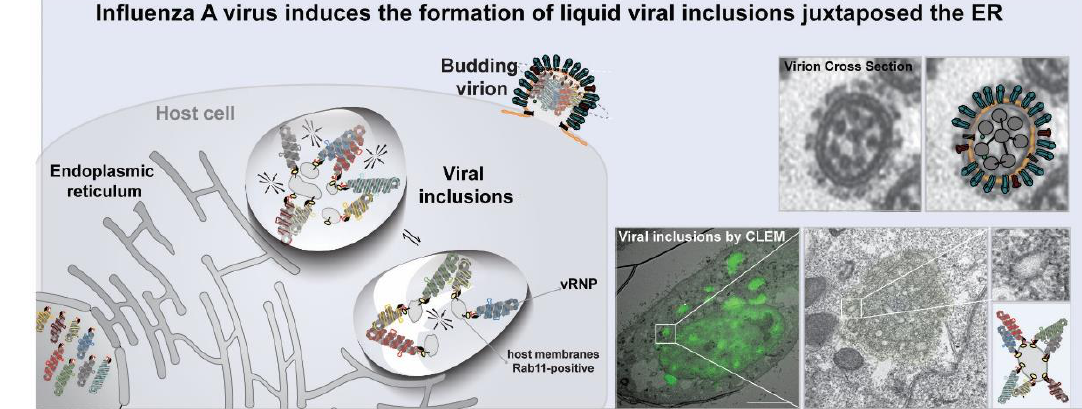
Figure 6. In IAV infection, viral ribonucleoproteins (vRNPs) concentrate in liquid compartments devoid of delimiting membranes—see correlative light and electron microscopy (CLEM) image—prior to be packaged into budding virions. CLEM also reveals membranes (inside) IAV liquid inclusions and electron dense material that resembles vRNPs in budding virions. Top right shows a cross-section of virions with eight vRNPs arranged as seven segments surrounding a central piece (reviewed in [190]).